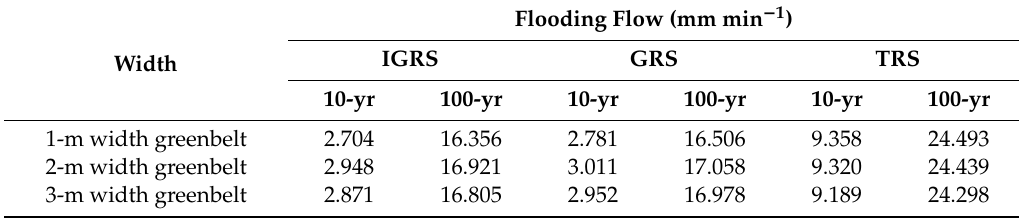
Table 8. Comparison of the flooding flow among the GRS, IGRS, and TRS in the single event simulation.